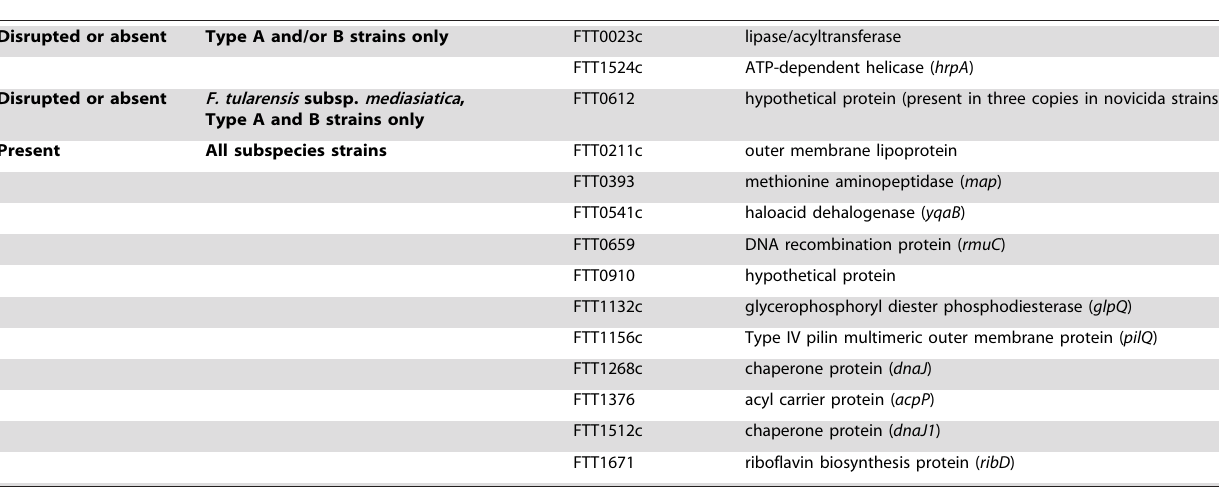
Table 4. Phylogenetic Differentiation Associated with Gain and Loss of Genes with Sequence Similarity to T3SS Effectors.